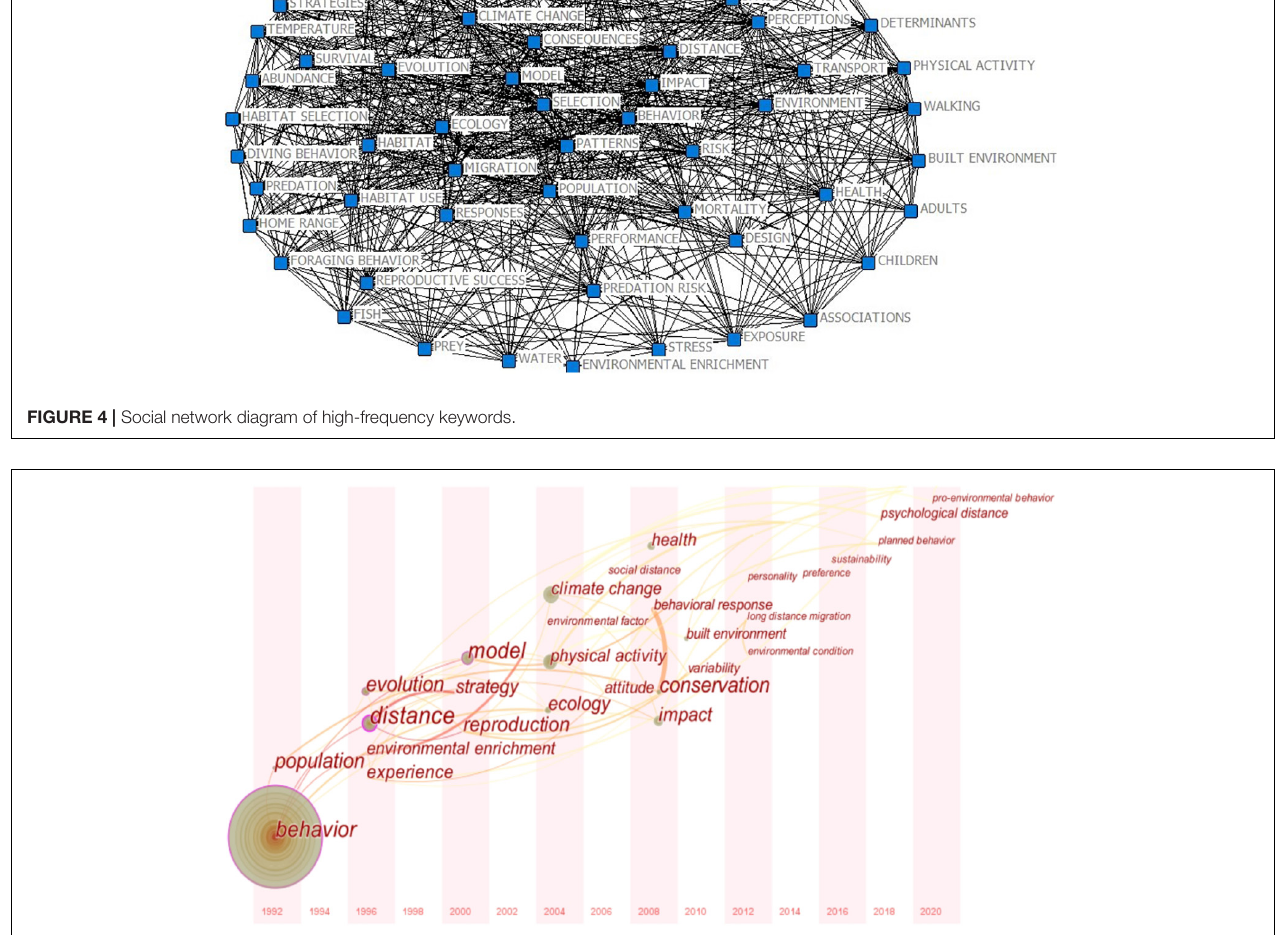
FIGURE 5 | Keyword time zone evolution